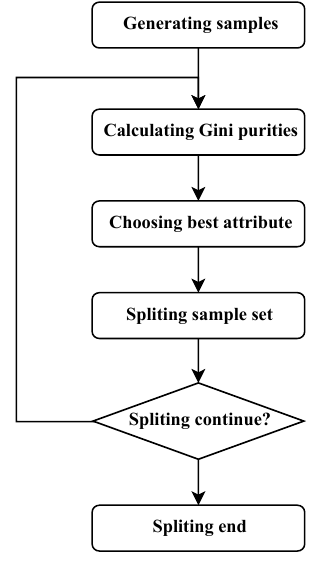
Figure 2. Flow chart of CART base learner